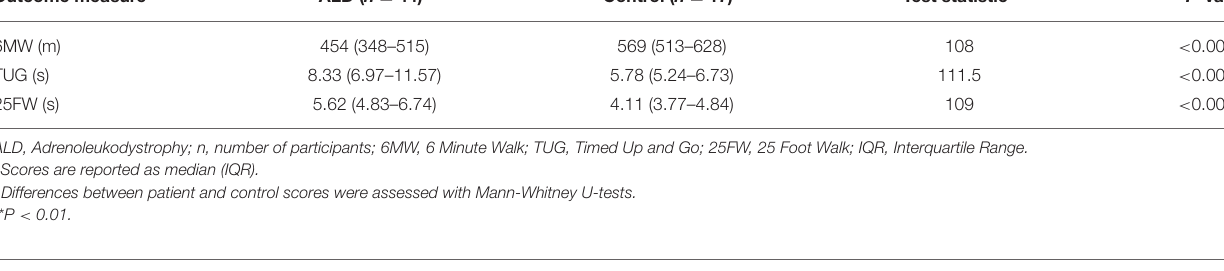
TABLE 2 | Performance on gait assessment outcomes for patients and controls. Outcome measure